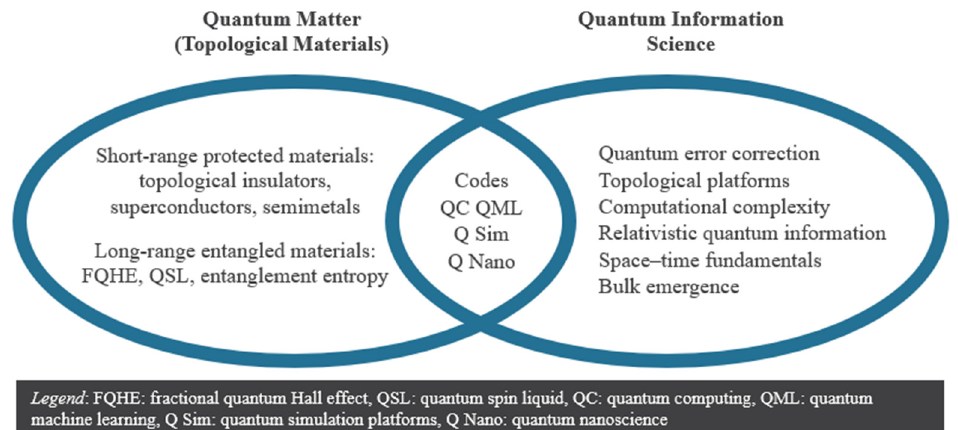
Figure 1. Research Topics in Quantum Matter and Quantum Information Science.